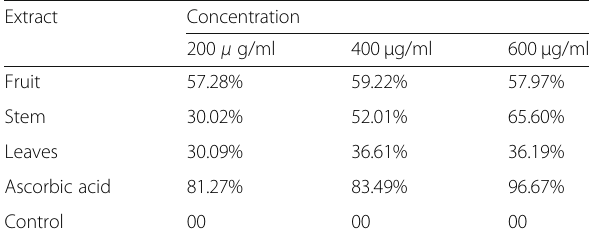
Table 3 %Antioxidant activity of chloroform extracts by DPPH method [20,